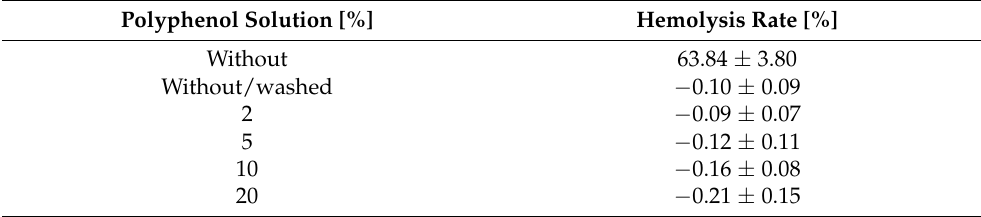
Figure 9. In vitro hemocompatibility assay left: hemolysis; right: no hemolysis. Table 3. Hemolysis rate for chitosan/glyoxal hydrogels after immersion in polyphenol solutions at 2%, 5%, 10%, and 20% concentration and without immersion for hydrogels washed and unwashed by distilled water.